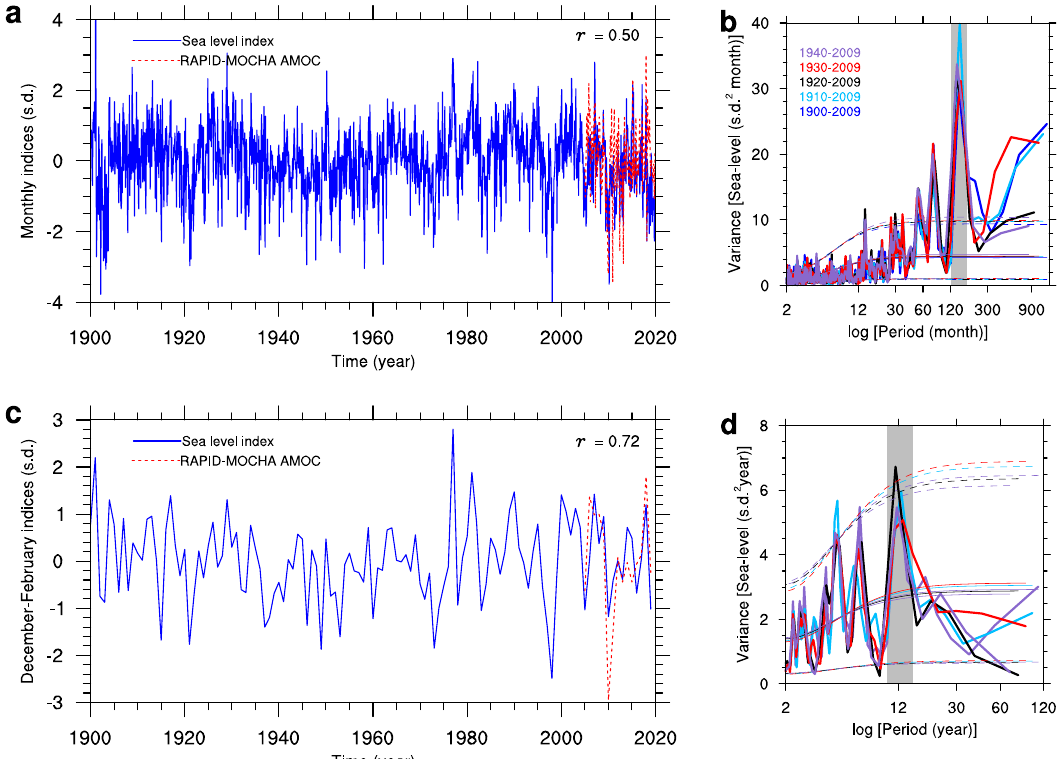
Fig. 1 The sea level-derived ocean circulation index. a Normalized monthly sea-level index used as a proxy for ocean circulation variability (solid, blue curve) 1900-2019 and AMOC measurements from the RAPID-MOCHA array (dashed, red curve, 2005-2019). b Spectra of the monthly sea-level index (thick, solid), its fi rst-order autoregressive fi t (solid, thin) and 95% con fi dence bounds (thin, dashed) for the different time slices indicated in the top-left corner of ( b ). c , d Similar to ( a , b ), respectively, but based on December – February data. The correlations ( r ) between the sea-level and AMOC time series for the common period from 2005 to 2019 are indicated in the top-right corner of ( a , c ). The vertical grey bars in ( b , d ) show the 10 – 15 year period